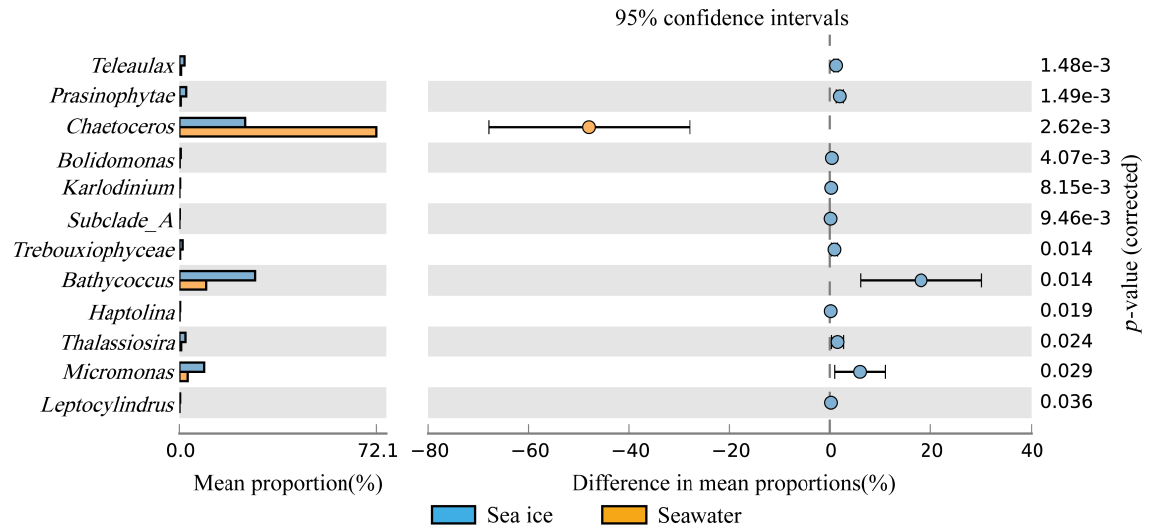
Figure 5. Comparison of genus-level differences between the seawater and the sea ice eukaryotic microalgal community ( t -test in STAMP). Color: Eukaryotic microalgae in the seawater (orange) and in the sea ice (blue).